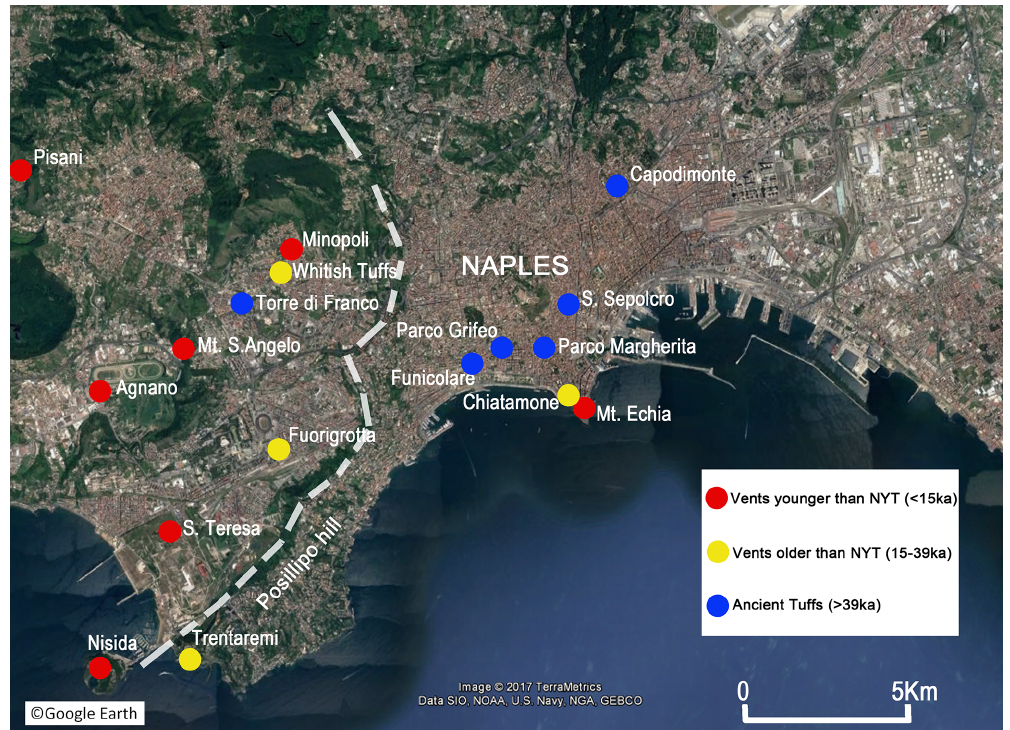
Figure 3. The city of Naples with the location of the eruptive vents associated with different eruptive periods. The dotted line represents the eastern boundary of the caldera of Campi Flegrei (modified after Scarpati et al., 2013 and Carlino, 2019; base map is from © Google Earth).